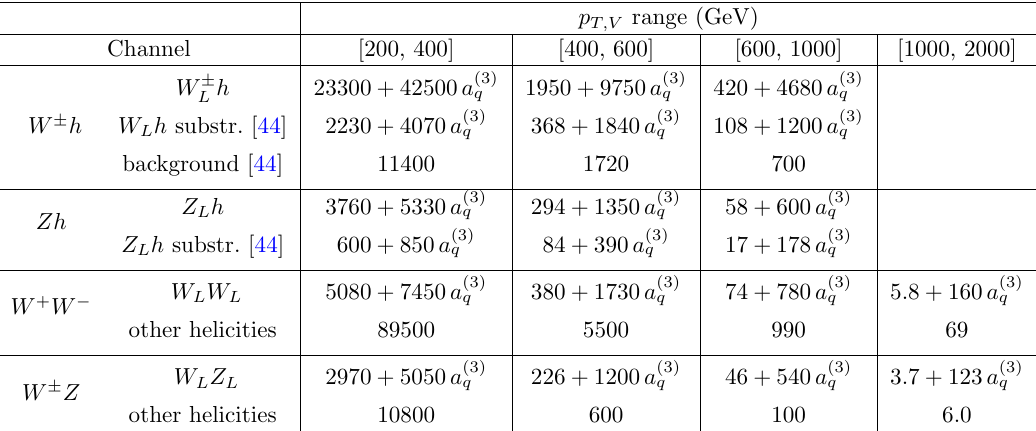
1 for the various (cid:0)